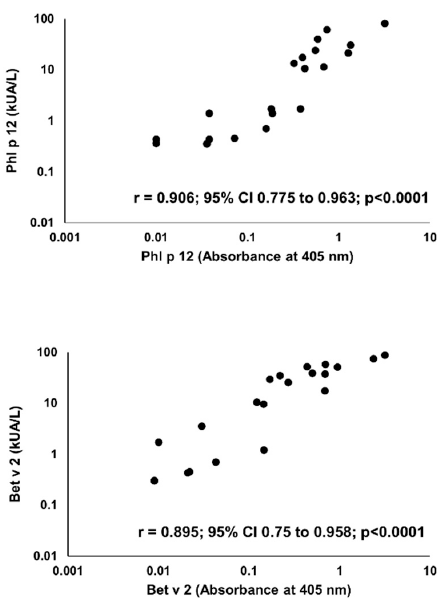
Figure 5. Correlation between IgE ELISA (X-axis) and multiparameter immunoblot (Y-axis) results for Phl p 12 ( upper panel ) and Bet v 2 ( lower panel ).